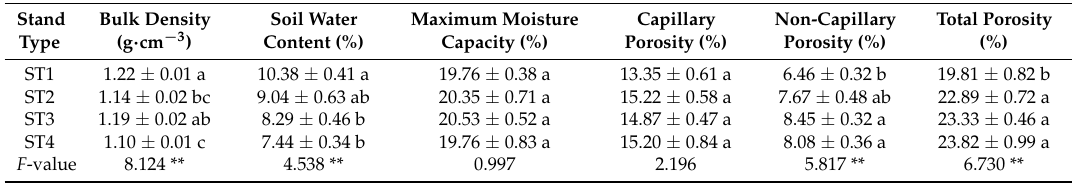
Table 4. Water-related physical properties of soil in four stand types of JRP pure